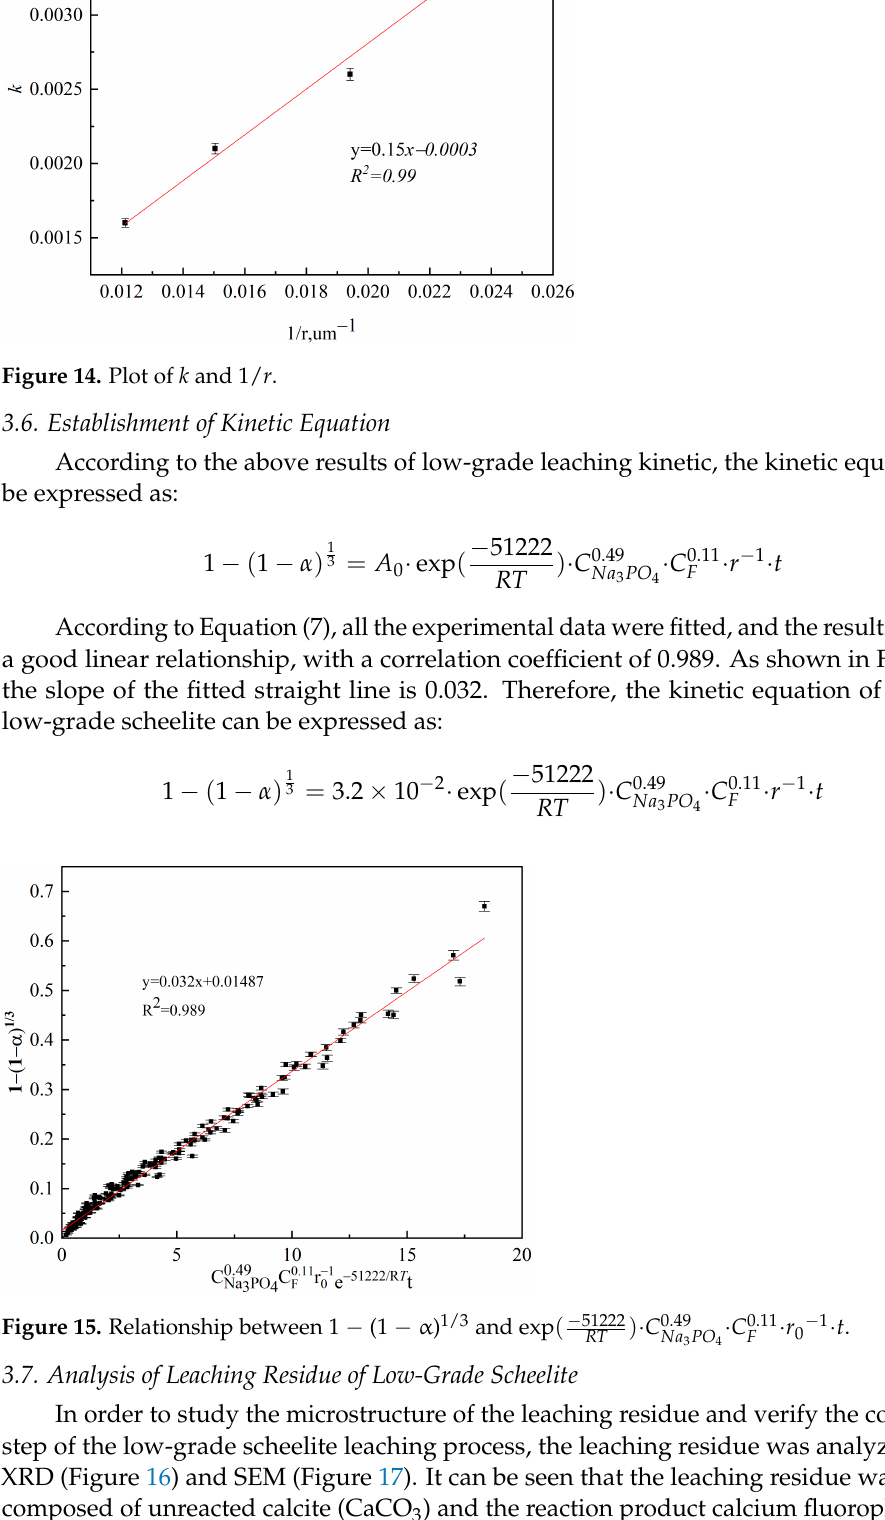
Figure 13. Relationship between 1 − (1 − α ) 1/3 and t at different mineral particle sizes.